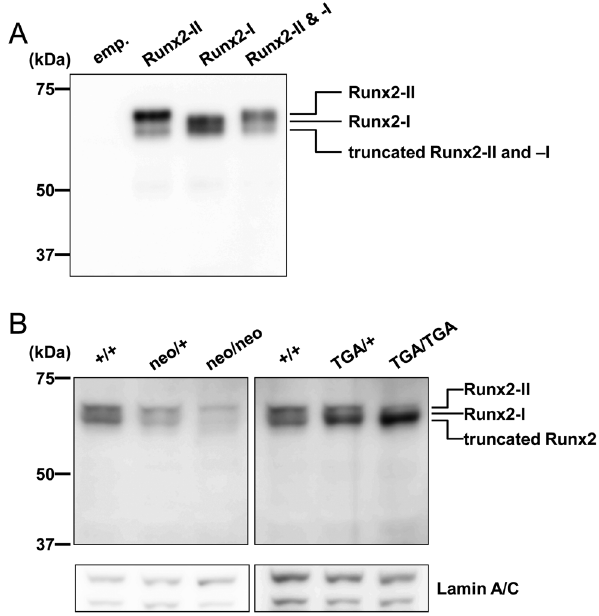
Figure 5. Runx2-I was expressed in Runx2-I TGA/TGA mice as N- terminal truncated Runx2. (A) Anti-Runx2 mAb (clone: 8G5) could recognize Runx2-II, Runx2-I, and their truncated versions. HEK293 cells were transiently transfected with the indicated expression vectors (see Materials and Methods). Forty-eight hours after transfection, nuclear proteins were obtained from the cells and then immunoblotted with anti-Runx2 mAb. (B) Nuclear proteins of calvarial cells freshly prepared from embryos (18.5 dpc) with the genotypes indicated in the figure were immunoblotted with anti-Runx2. The membranes were also blotted with anti-Lamin A/C mAb as an internal control. The data are representative of three independent experiments.